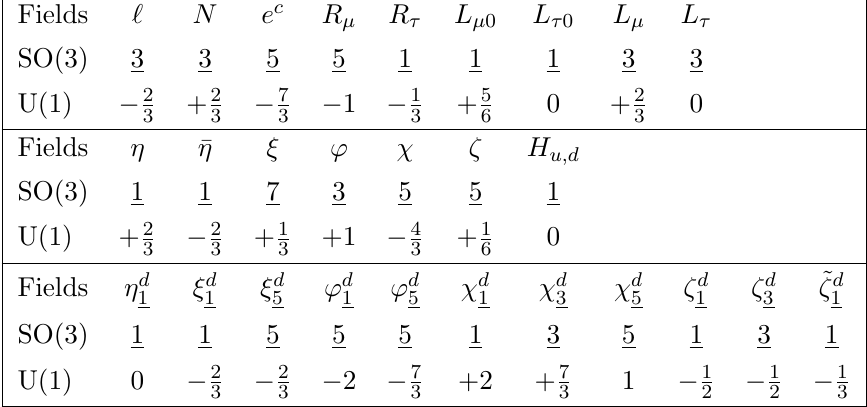
Table 3 . Field arrangements in SO(3) (cid:2) U(1) and decompositions of these (cid:12)elds in A SO(3) (cid:2) U(1) is broken to A 4